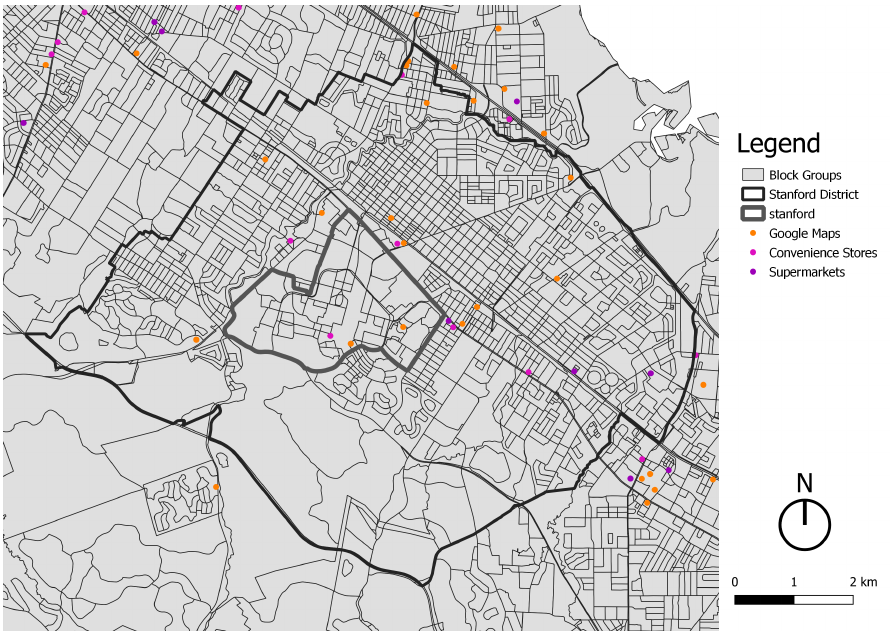
Figure 11. Location of supermarkets and convenience stores in Stanford District merging Open- StreetMap and Google Maps